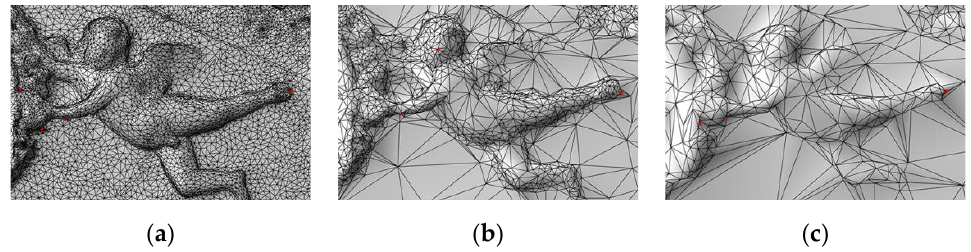
Figure 4. Illustration of our algorithm’s accuracy: ( a ) visual example of the angelo-2L.obj renderings multiplied by ranked criteria, ( b ) spatial position of the top-60 ordered vertices out of 4056.